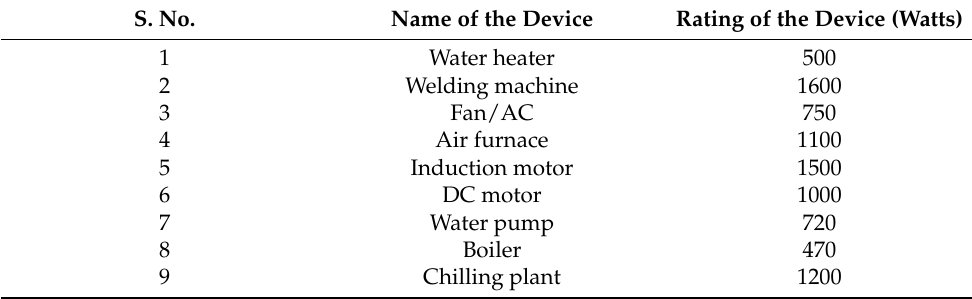
Table 4. Details of the industrial load.